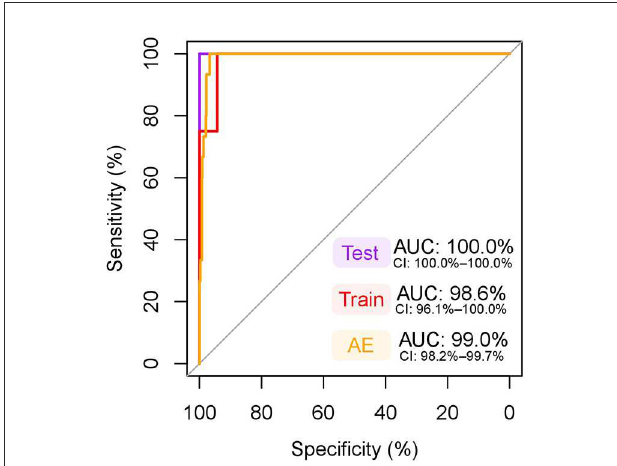
FIGURE5 ROC curve of the multivariate model for classification of pregnant dogs. The dependent variables included in this model were albumin and glycoprotein acetyls (GlycA). An area under the curve (AUC) nearing 100% is considered excellent. Test: receiver operating characteristic (ROC) curve, AUC, and its 95% confidence intervals (CI) in testing data (pseudopregnant n = 8, pregnant n = 3), used to test the model fit in a sample set independent from the training data. Note, that the CI for an AUC of 100% is not defined. Train: ROC curve, AUC, and its 95% CI in training data (pseudopregnant n = 35, pregnant n = 12), which was used to create the model. The testing and training datasets were randomly split prior to model generation from data including all pregnant ( n = 15) and pseudopregnant ( n = 43) dogs to cover 20% and 80% of the samples, respectively. AE: ROC curve, AUC, and its 95% CI in the data including dogs in anestrus ( n = 663) and all pregnant ( n = 15) dogs. This data was used to test the model in a larger dataset of female